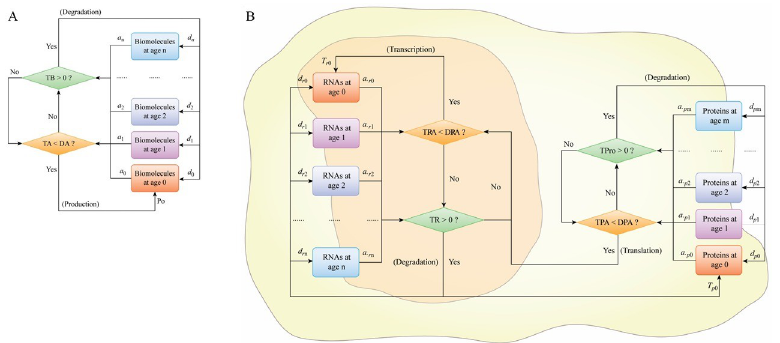
Fig 8. Models of biomolecular level fluctuations. (A) A one-unit model of biomolecular level fluctuations in a cell. TB represents the total abundance of biomolecules at all biomolecular ages. TA represents total biomolecular activity at all biomolecular ages. DA represents the demands of biomolecular activity in the cell. DA is influenced by stimuli from intra- and extracellular environments, and the difference between TA and DA determines the trigger or cessation of biomolecule production. d 0 , d 1 , d 2 , ... , d n are degradation coefficients. α 0 , α 1 , α 2 , ... , α n are activity coefficients. P 0 represents the level of nascent biomolecules per time. (B) A two-unit model of level fluctuations of RNAs and proteins derived from a gene in a cell. TR is the total amount of RNA at all ages. TRA is the total RNA activity at all ages. DRA is the demands for RNA activity. TPro is the total amount of protein at all ages. TPA is the total protein activity at all ages. DPA is the demands for protein activity. DPA corresponds to the external and internal stimuli. The differences between TPA and DPA and that between TRA and DRA define the intensity of the production and/or the degradation of proteins and RNAs, respectively. d r 0 , d r 1 , d r 2 , ... , d r n are degradation coefficients of RNA. d p 0 , d p 1 , d r 2 , ... , d p n are degradation coefficients of protein. α , α , α , ... , α are the activity coefficients of RNA. α , α , α , ... , α are r 0 r 1 r 2 r n p 0 p 1 p 2 p n the activity coefficients of the protein. T is the amount of nascent RNA per time. T is the amount of nascent protein r 0 p 0 per